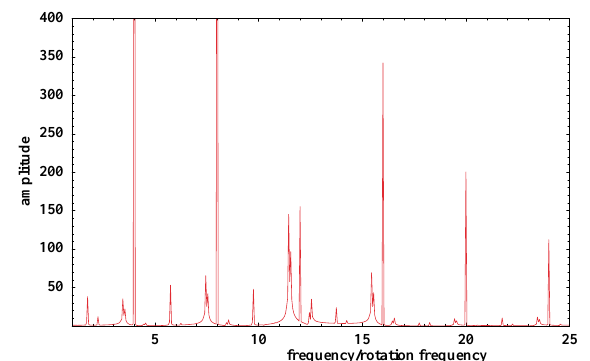
FIG. 26. (Color) Spectrum of (cid:5) y 4 (cid:6) after 250 turns. (cid:1) 4 (cid:1) n V 2 31 Dn (cid:2) . With our previous assumption of 4 0 32 ¯ n y (cid:4) 5.7 we thus have V 4 (cid:4) 22.8 . In fact, Fig. 26 shows a peak around this number. Based on this spectrum analy- sis, the nature of the observed resonance appears to be associated with the development of a high-order collective beam mode driven by the space-charge coupling resonance rather than with the lattice harmonics. At a later stage of the calculation, we observe the resonance between indi- vidual particles with depressed tune and the fourth order coherent beam mode ( 4 ˜ n y (cid:1) V 4 ) as these particles enter the